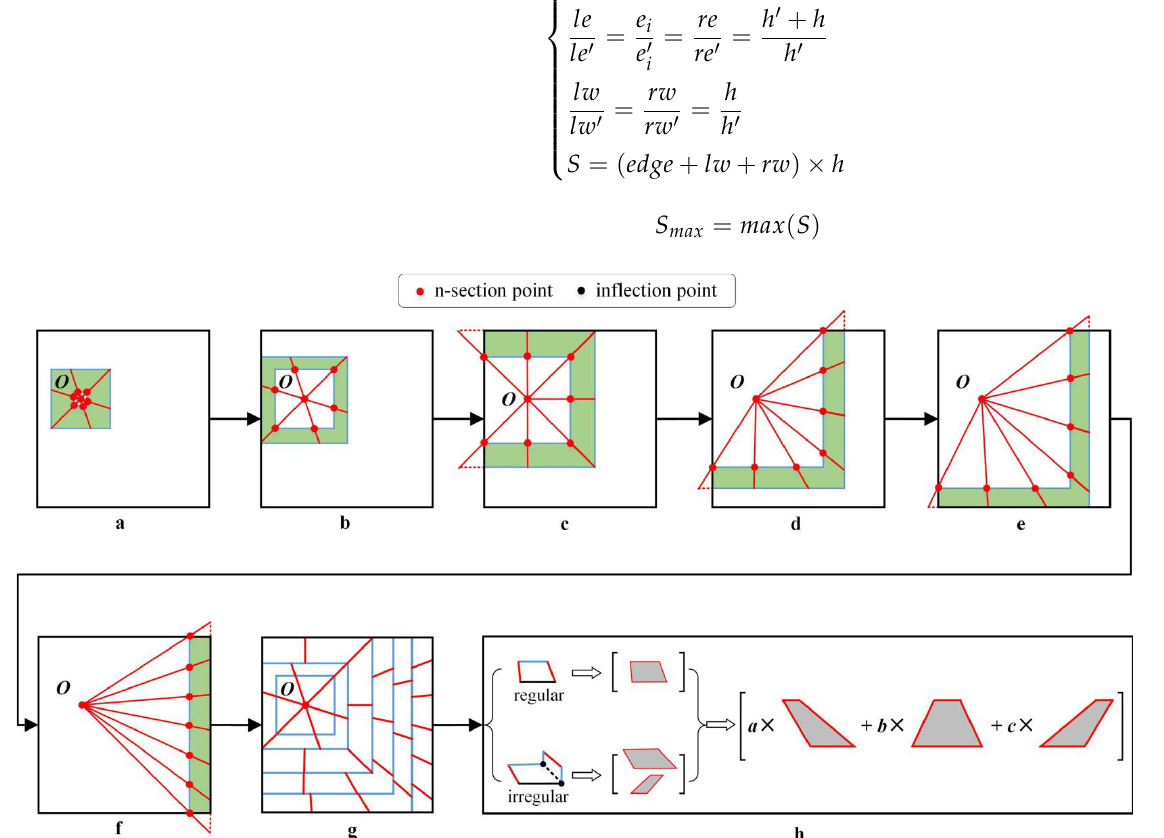
Figure 5. The details of function F in the Multi-level Data Decomposition Strategy ( m = 6, n = 6, a , c ∈ { 0,1 } , 0 ≤ b ≤ 4). ( a – g ) are the divisions of ( level 1 , level 2 , level 3 , level 4 , level 5 , level 6 ), and ( h ) is the details of the decomposed fragments.